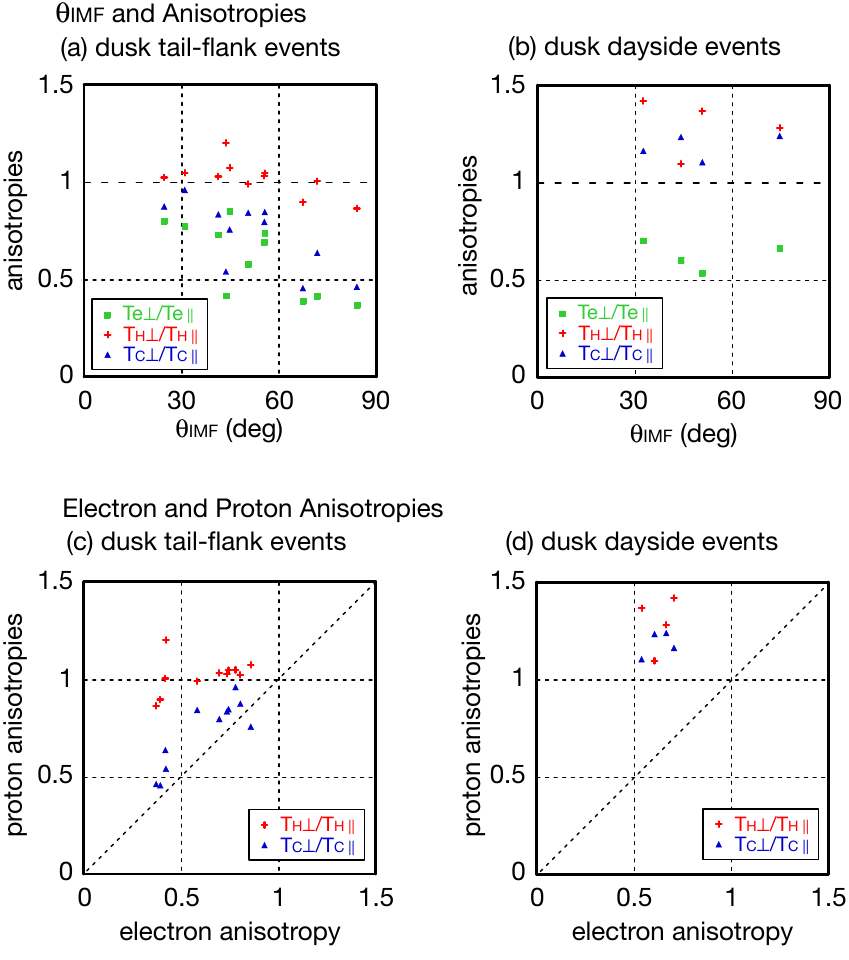
Fig. 10. Statistical plots of observed temperature anisotropies. The top two panels show the dependence of the anisotropies on the IMF lati- tudinal angle ( θ IMF ) for (a) tail-flank events and (b) dayside events. The bottom two panels present the relation between electron anisotropy and proton anisotropies for (c) the tail-flank and (d) the dayside events. Green squares, blue triangles, and red plus symbols correspond to the anisotropies of the electrons, the cold proton component, and the hot proton component,